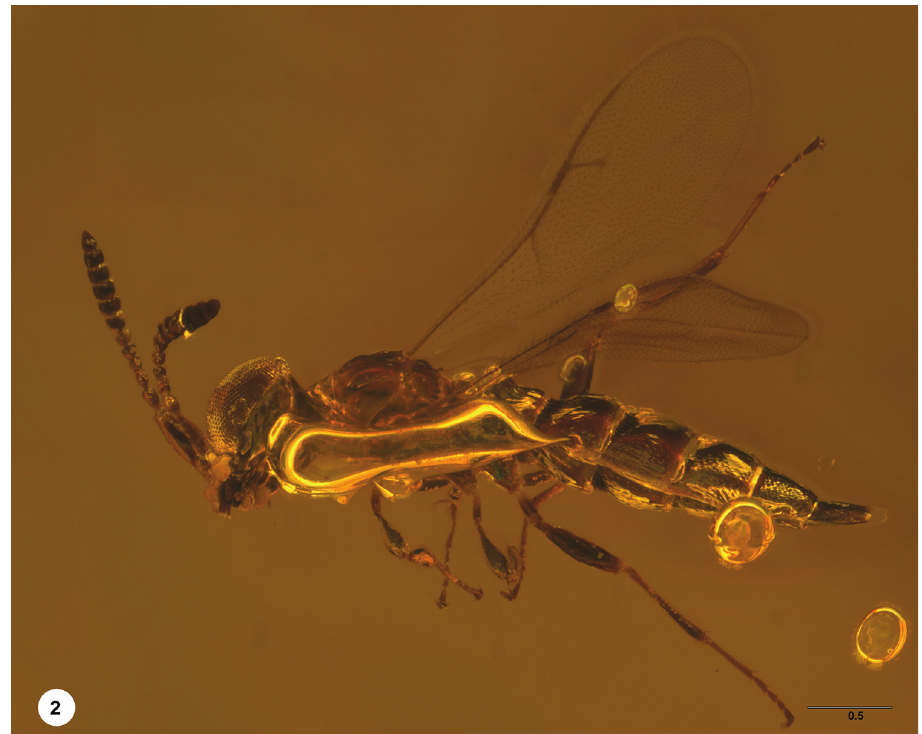
Figure 2. Archaeoteleia astropulvis , female holotype (USNMENT01109982), habitus, dorsolateral view. Scale bars in